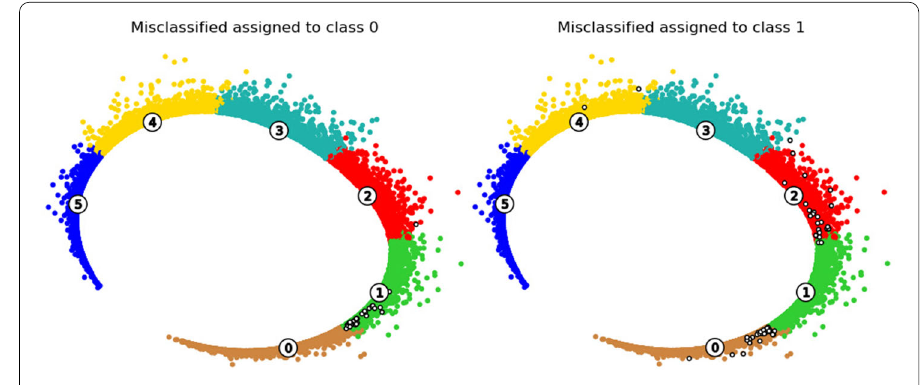
Fig. 10 Misclassified examples (classes 0 and 1)